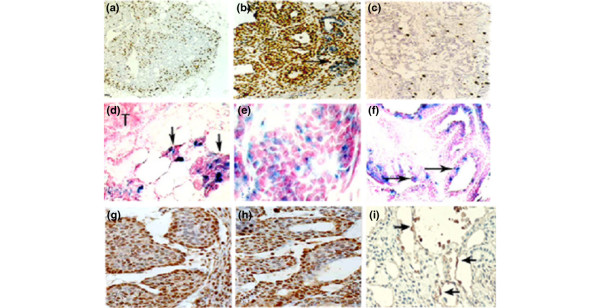
DHEA and DHEA8354 induce cellular senescence, inhibit cell proliferation and increase apoptosis in mammary tumors. (a-c) Cell proliferation in control mammary tumors (a,b) and in tumors treated with dehydroepiandrosterone (DHEA) (c). DHEA significantly decreased the proportion of bromodeoxyuridine-labeled cells (c). The slide was counterstained with hematoxylin; original magnification × 100. (d-f) DHEA-induced cellular senescence (SA-β-Gal-stained cells) in normal lobular cells (d, arrows) and in mammary tumors (e and f, arrows). (g,h) p21 and p16 were expressed in most mammary tumor cells. DHEA also induced tumor disintegration and in these areas p16 (arrows) was preferentially detected in tumor areas where SA-β-Gal-stained cells were also identified.